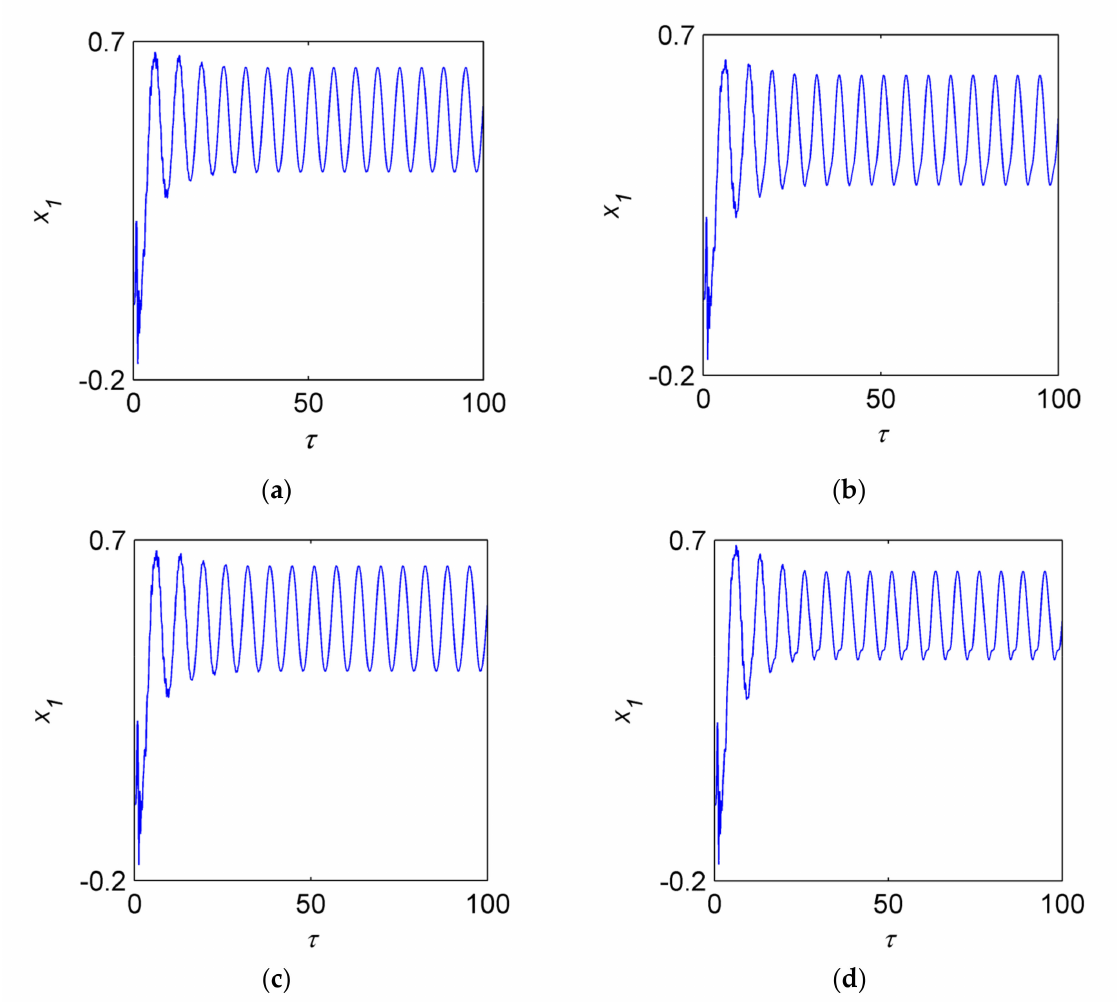
Figure 5. Time history curves of x 1 when ω = 350 rad/s. ( a ) The oil-filmed system. ( b ) The cracked system. ( c ) The rub-impacted system. ( d ) The coupled